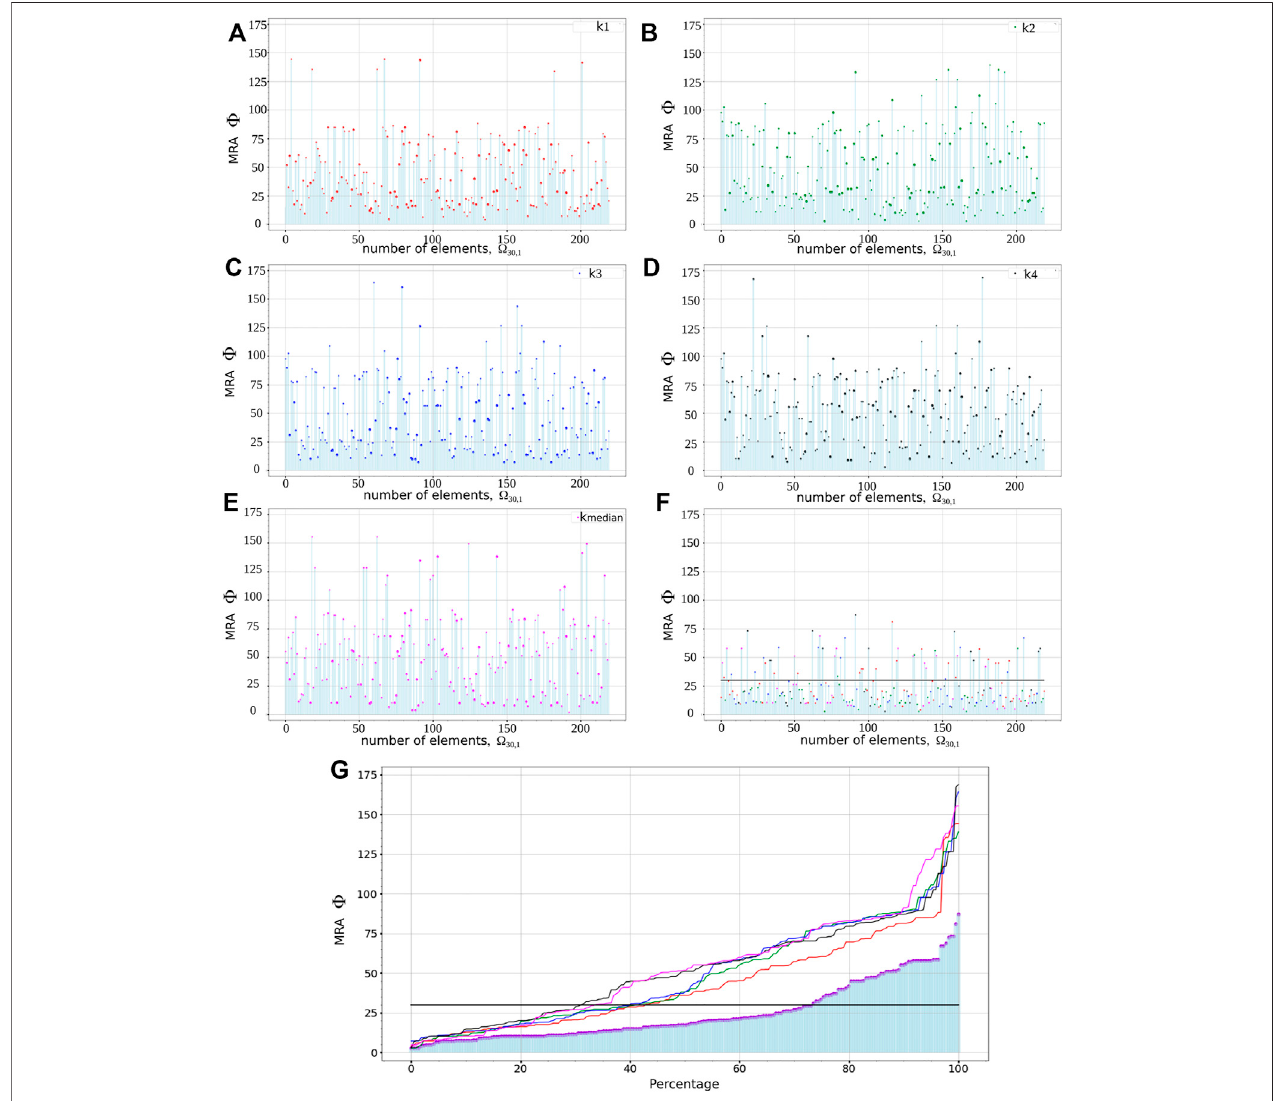
FIGURE6| StatisticalmetricsresultsintheNewZealandregion.Eachsubplotdepictsthe Φ computedforeach new -event vs .thefournearestneighbors k1 (A) , k2 (B) , k3 (C) , k4 (D) , and k -Median (E) . The minimum values between these fi ve statistical solutions are depicted in subplot (F) where the horizontal line indicates the threshold Φ < 30 ° . (G) shows the ordered values of the other subplots in same colors except the dark-violet that corresponds to the minimum value in subplot (F) .